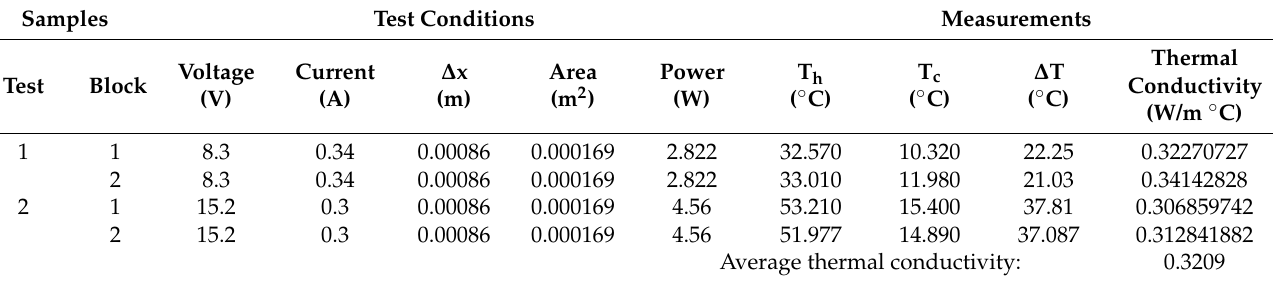
Table 2. Measurements of thermal conductivity by hot plate